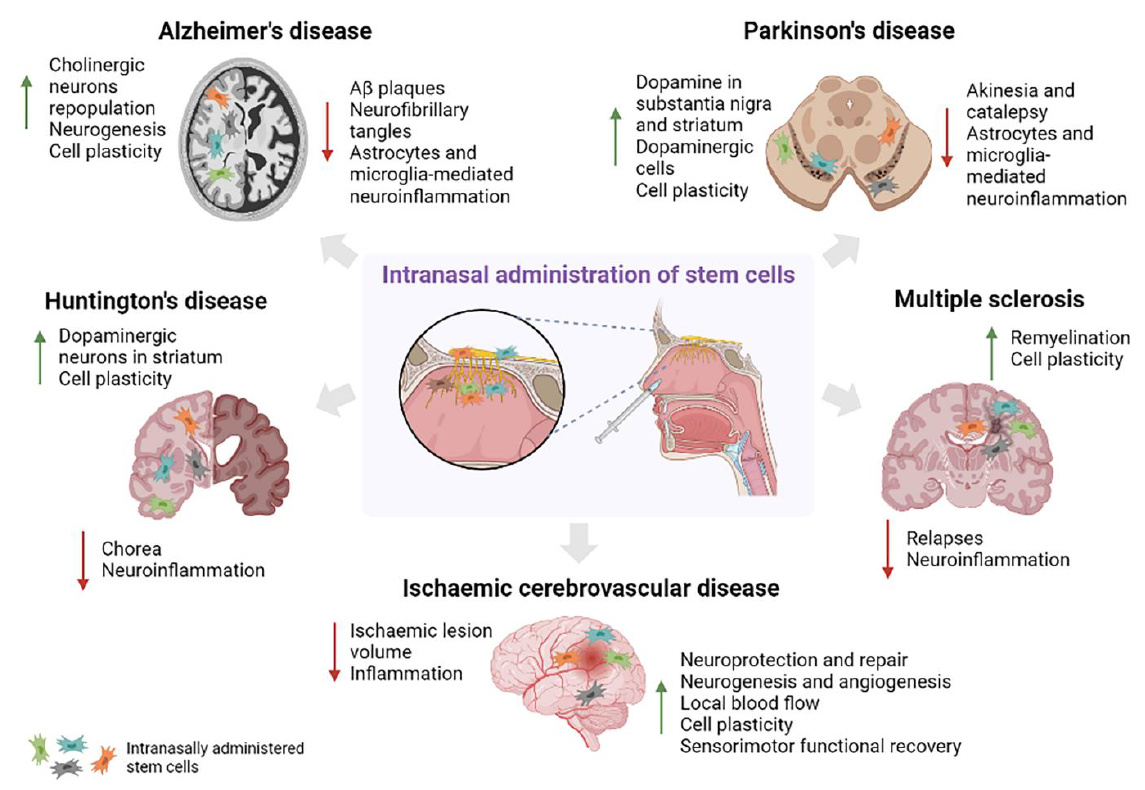
Figure 1. Expected effects of cell therapy administered via the intranasal route in the treatment of neurodegenerative and cerebrovascular diseases. The gray arrows indicate the possible therapeutic effects in the main pathologies.